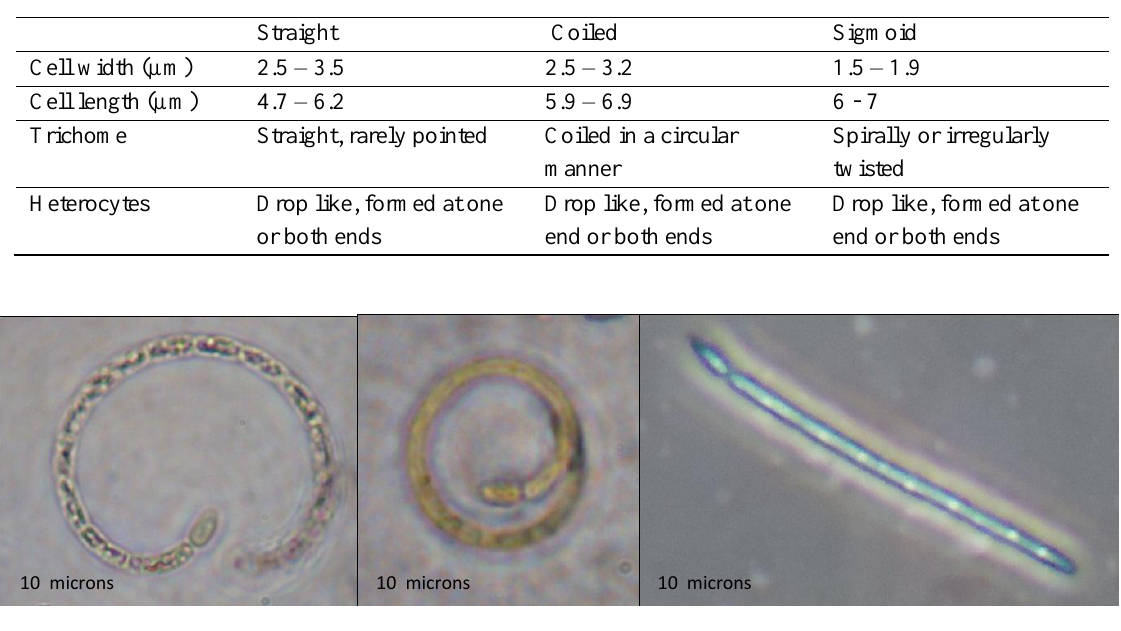
Figure 5 : Photomicrographs showing morphological variations of C.raciborskii from Sri Lankan reservoirs.